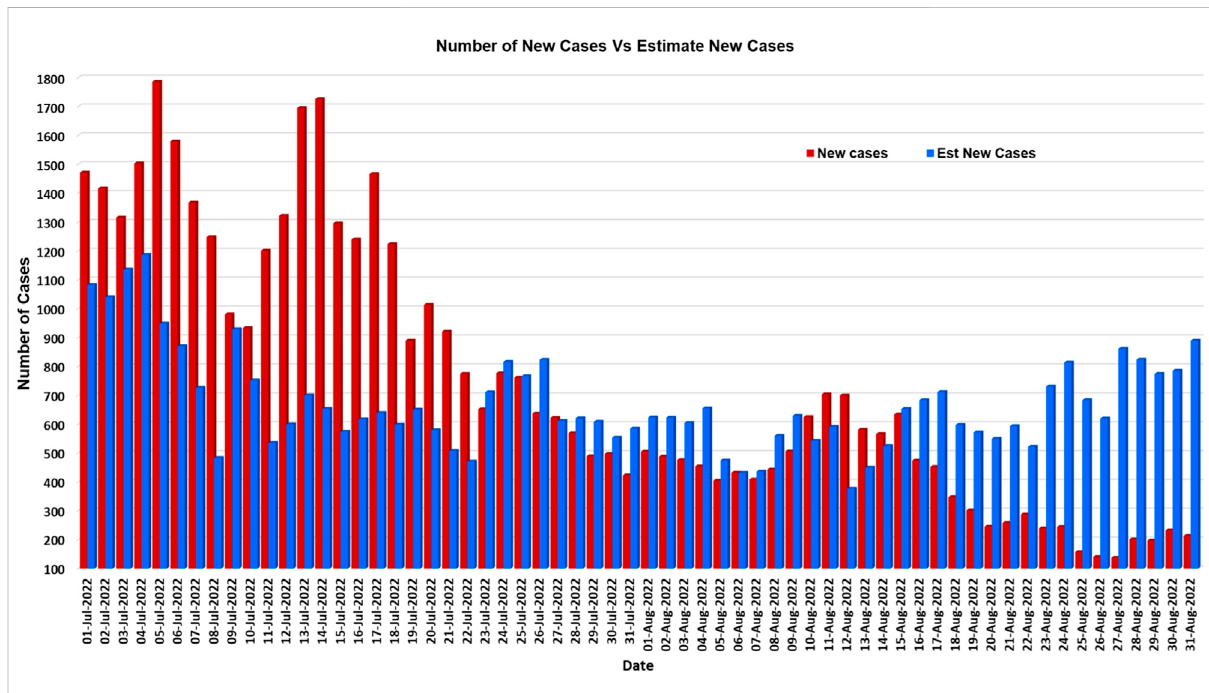
FIGURE 12 Comparison between the actual number of infected cases by SARS-CoV-2 in Bahrain for the period post of the recorded data for 27 months, i.e., infected cases from 1 July to 31 August (60 data